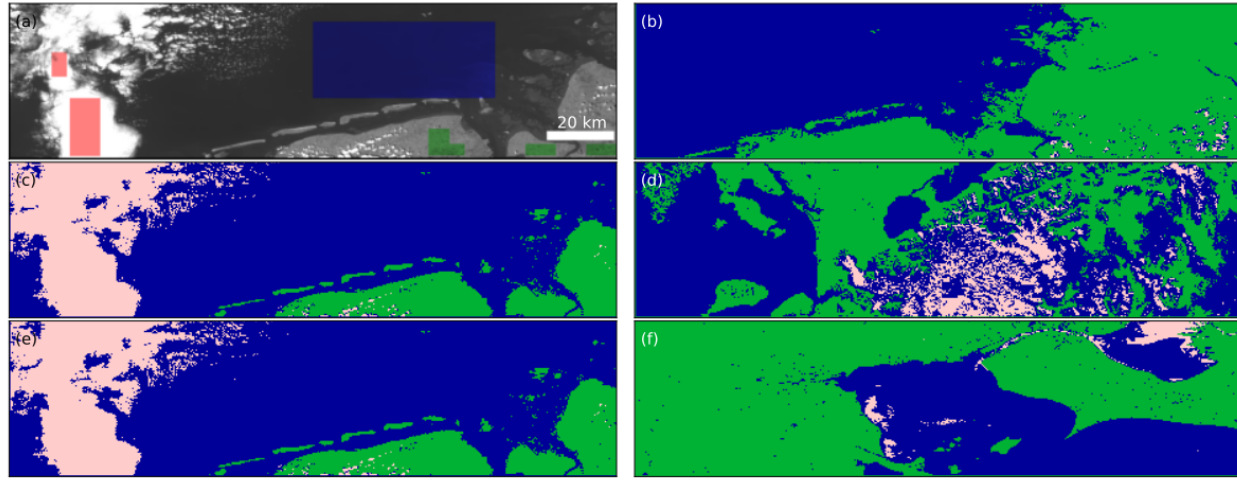
Figure 14. ( a ) The pixels assigned to the water ( blue ), land ( green ), and cloud ( red ) for the initial determination of labels. The labels assigned according to ( c ) the full 86-band SOM or ( e ) the five-band DR SOM. The DR SOM classification applied to ( b ) second North Sea scene, ( d ) the Chilean scene, and ( f ) Lake Erie.